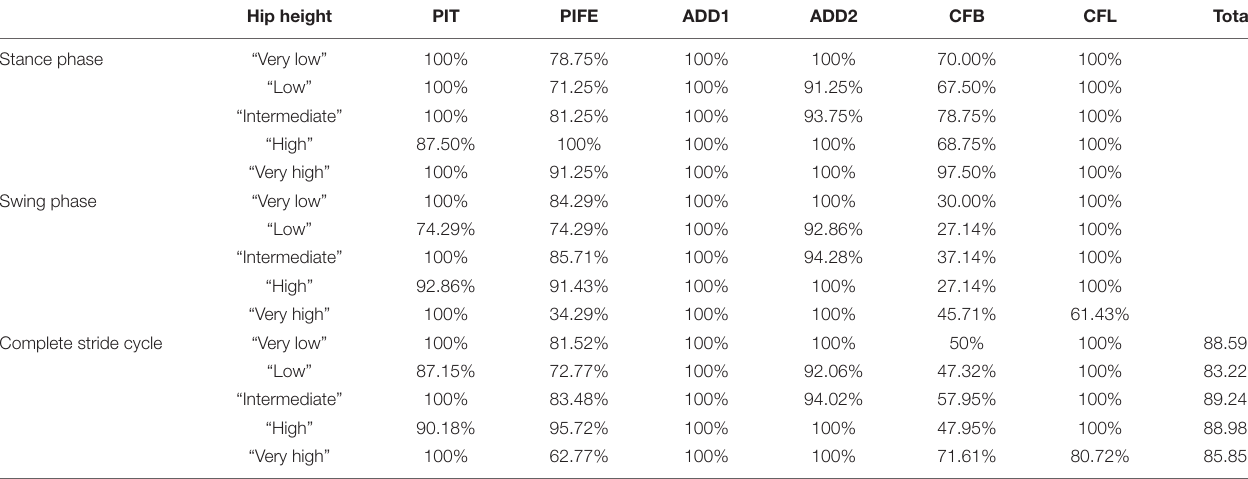
TABLE 2 | Percentage of the stride cycle that a modeled muscle maintained optimal muscle strain (i.e., within 70 and 130% of reference length) in Orobates. Hip